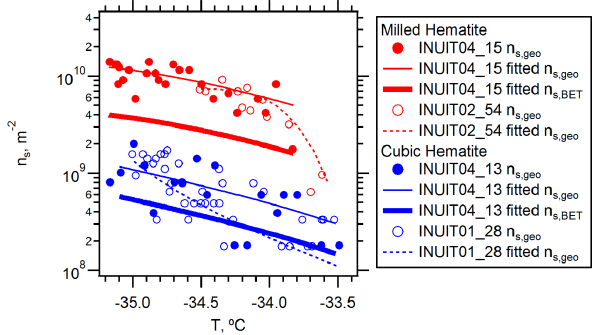
Fig. 3. INAS densities, geometric area-based n s , geo and BET- inferred n s , BET , for immersion freezing of cubic and milled hematite particles as a function of temperature, T . The thin solid lines correspond to fitted n s , geo of INUIT04_15 and INUIT04_13 and the thin dashed lines correspond to fitted n s , geo of INUIT02_54 and INUIT01_28. The bold solid lines represent the BET-inferred n s , BET of INUIT04_15 and INUIT04_13. Note that experimental uncertainties are T ± 0.3 ◦ C and n s ± 35% (Steinke et al.,